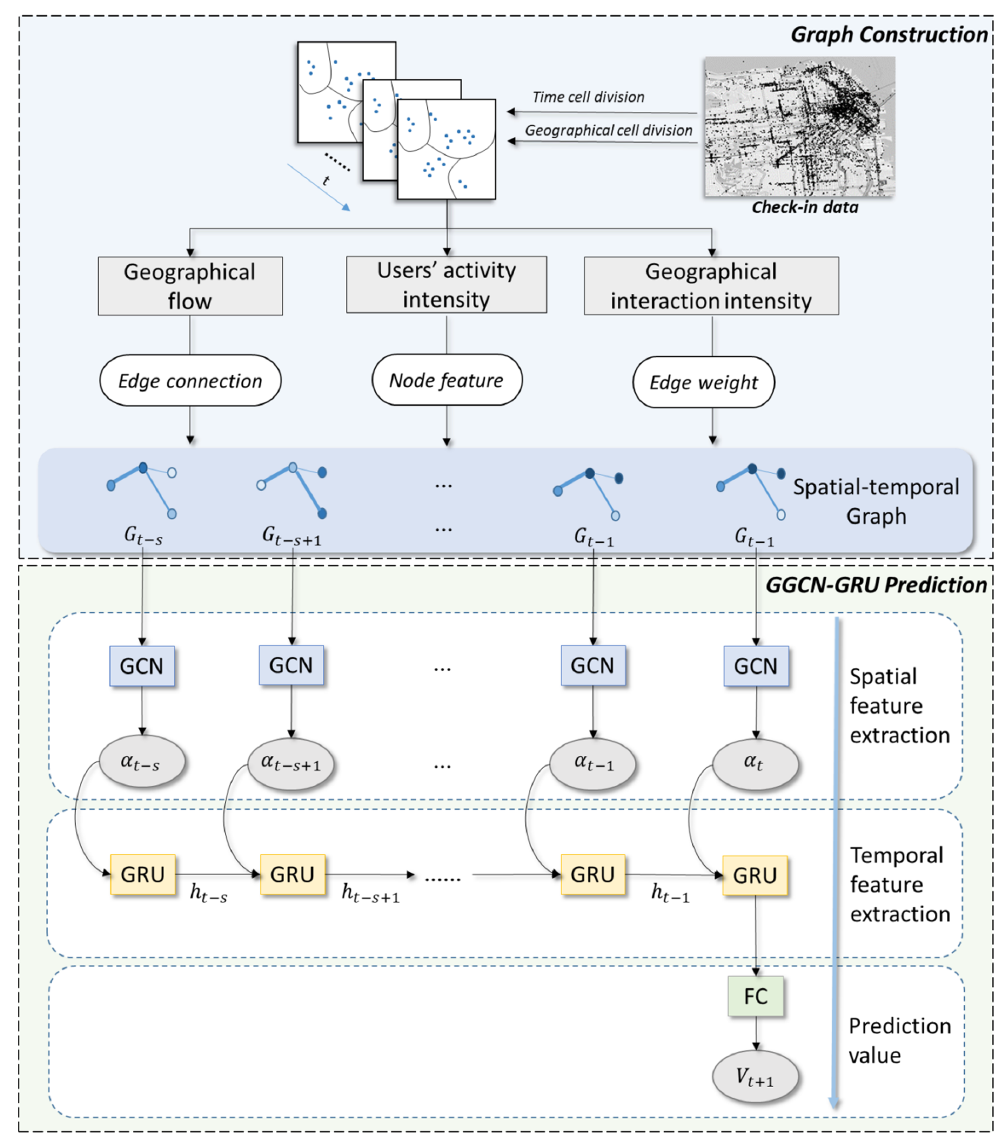
Figure 1. Architecture of the geographical interactions weighted graph convolutional network-gated recurrent unit (GGCN- GRU) approach. A spatial temporal graph based on geographical interactions is constructed and then input into the GCN and GRU to extract